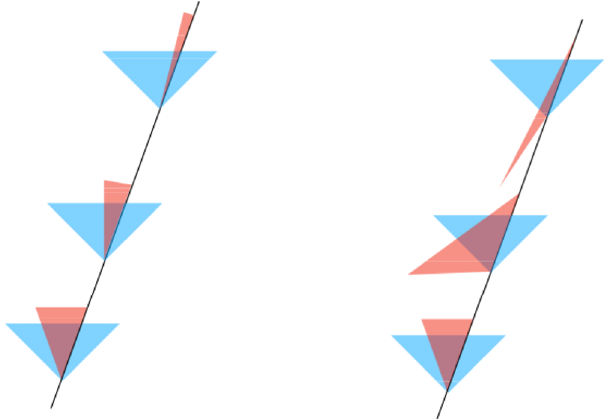
Figure 2 . Future causal cones for normal matter with speed of propagation c = 1 (blue) and the cubic galileon (red) for a right-moving subluminal simple wave, prior the caustic formation. The evolution of the causal cone is shown along the right propagating characteristic (cid:4) + = (cid:24) + . The left picture corresponds to the case of negative (cid:13)(cid:30) 00 , while the right picture is for positive (cid:13)(cid:30) 00